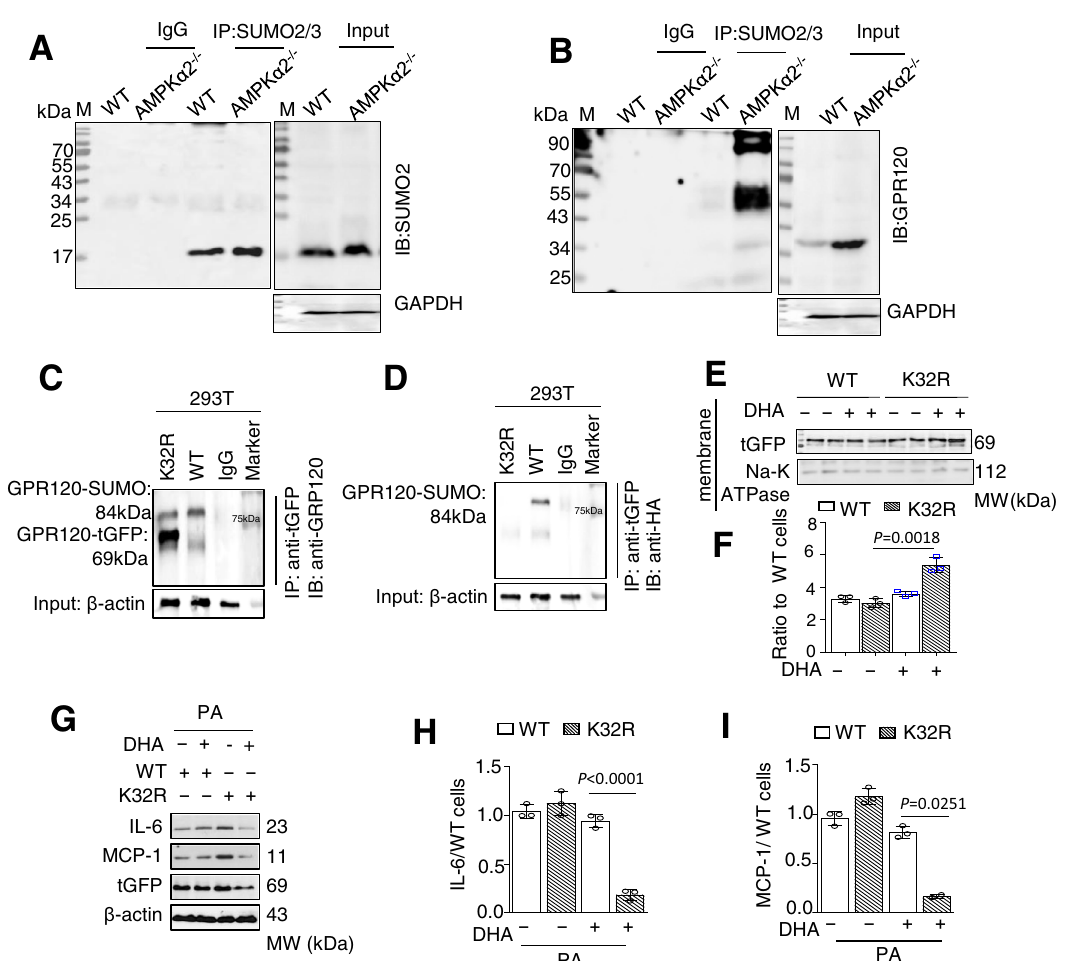
Fig. 5 | GPR120 SUMOylation at K32 blocked the effects of DHA in AMPK α 2 − / − cells. A , B IP assays showed endogenous GPR120 and SUMOylated GPR120 in WT and AMPK α 2 − / − VSMCs by western blotting of whole cell extracts, prepared in the presence of isopeptidase inhibitors ( C , D ) IP assays for whole cell extracts from 293T cells co-transfected with either the WT GPR120-tGFP or K32R/GPR120-tGFP vector and the SUMO2-HA vector. E , F Western blotting ( E ) and quanti fi cation ( F ) of tGFP expression in membrane fractions from AMPK α 2 − / − VSMCs transfected with GPR120-tGFP or K32R/GPR120-tGFP and treated for 1h with DHA. Scale bars,